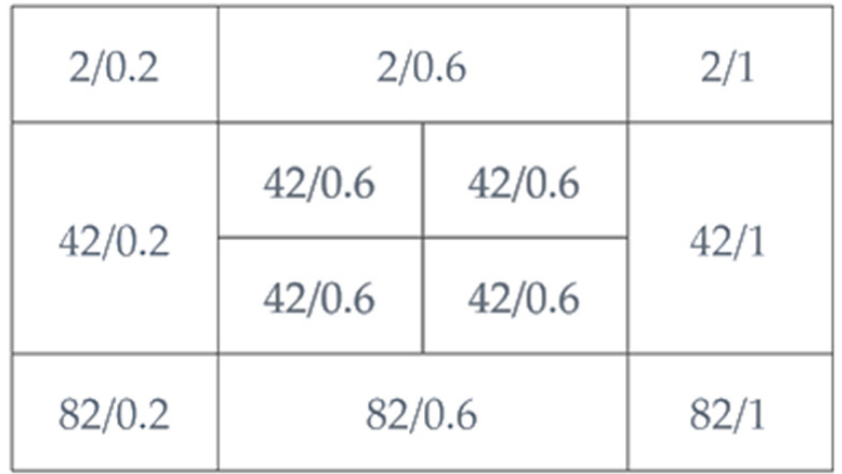
Figure 1. Matrix of the levels of N and P used in each experiment. Note that of the average conditions (42 ppm N and 0.6 ppm P) four replicates are (42 ppm N and 0.6 ppm P) four replicates are established.